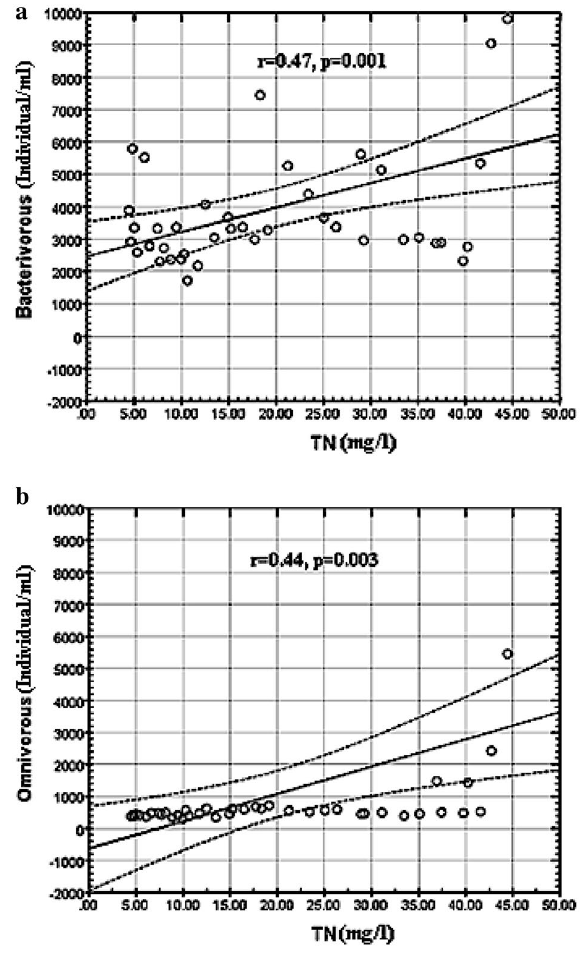
Figure 5. ( a , b ) Correlation between the trophic groups of protists and TN concentrations.